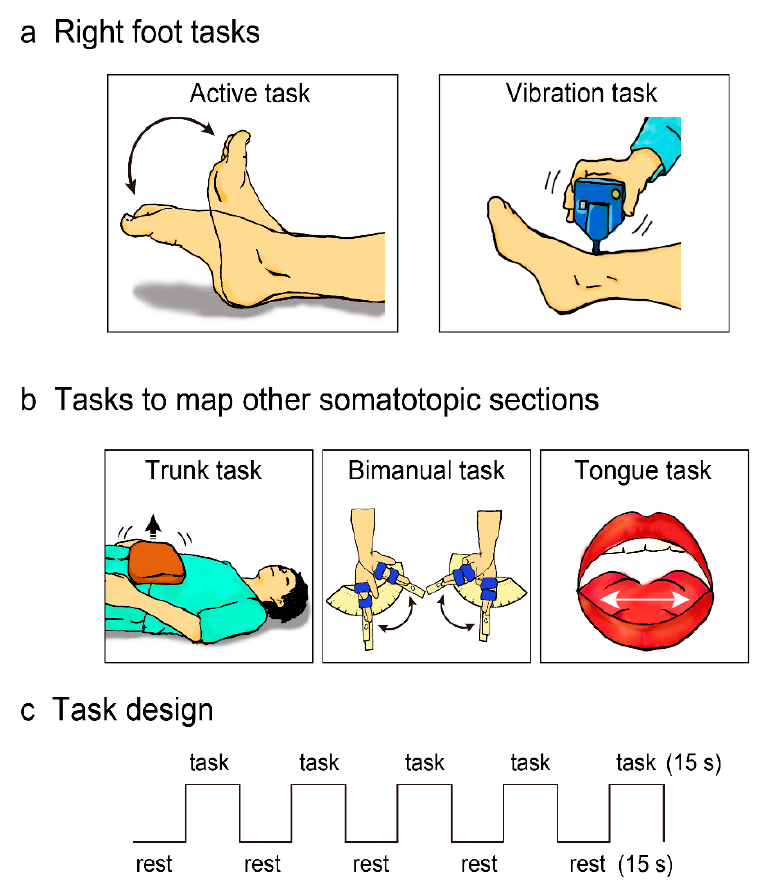
Figure 1. fMRI tasks and task design. ( a ): Right foot tasks. Active (left) and vibration (right) tasks. ( b ): Tasks for mapping other somatotopic sections. Trunk (left), bimanual (middle), and tongue (right) tasks. ( c ): Task design.